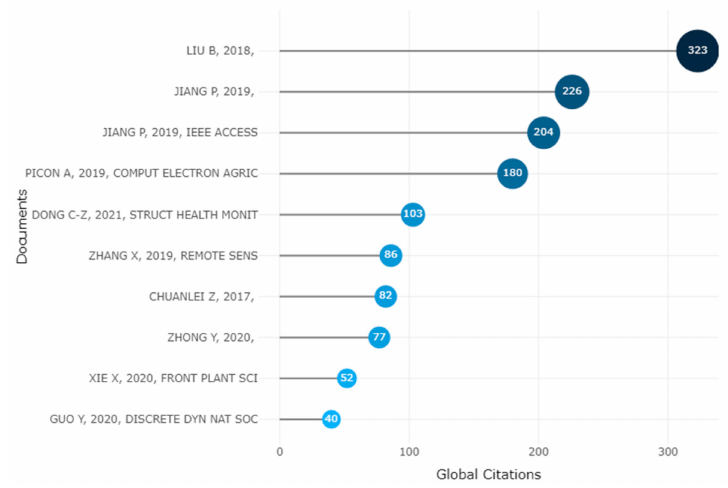
Figure 19. Ten Topmost Global Citations of Apple Leaves Disease [25,87–90]. Data access information source: http://www.scopus.com (accessed on 14 September 2022).